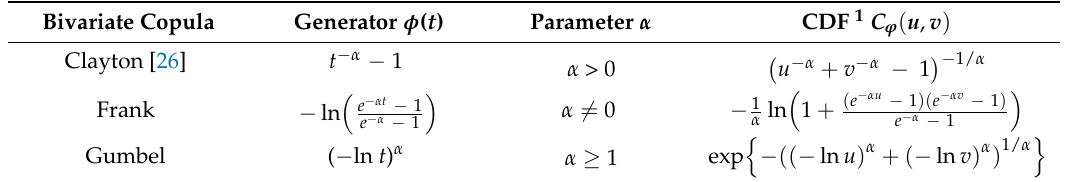
Table 1. Bivariate Archimedean copulas and their generators. Bivariate